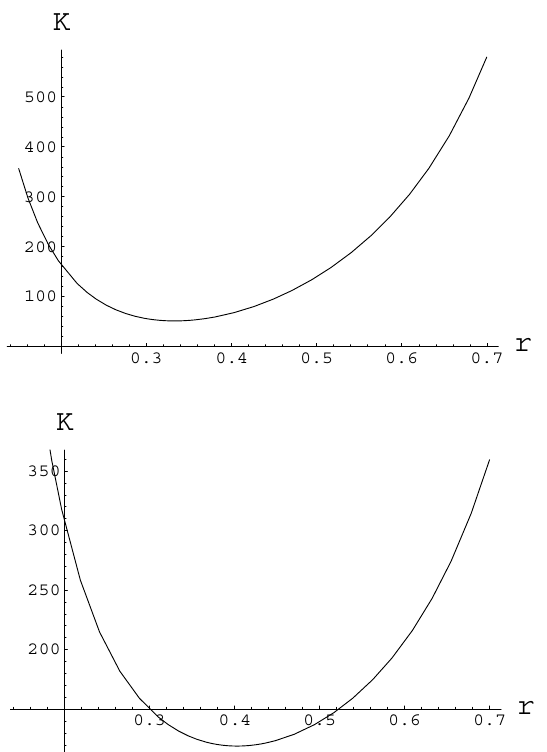
Fig. 3. ( a ) The real part (K) of the dispersion relation for thermal electron on closed magnetic field lines (Eq. (28)) at Mars shown ver- sus frequency below the electron gyrofrequency, r = ω/ω He . This curve is for a ratio of 0.25 between the concentrations of the tran- sient component and of the loss-cone distribution (the electron flux trapped in the “magnetic bottle”). The real part is positive in the whole frequency interval, indicating transparency. ( b ) Same as Fig. 3a, but here for a ratio of 0.4 between the concentration of the transient component and the component trapped in the “magnetic bottle”. The real part is negative for 0 . 3 <r< 0 . 5, indicating that waves within that range can not propagate. Thus, for increasing concentration in the magnetic bottle, (decreasing ration) the whole frequency range below the electron gyrofrequency becomes trans- parent (Fig.